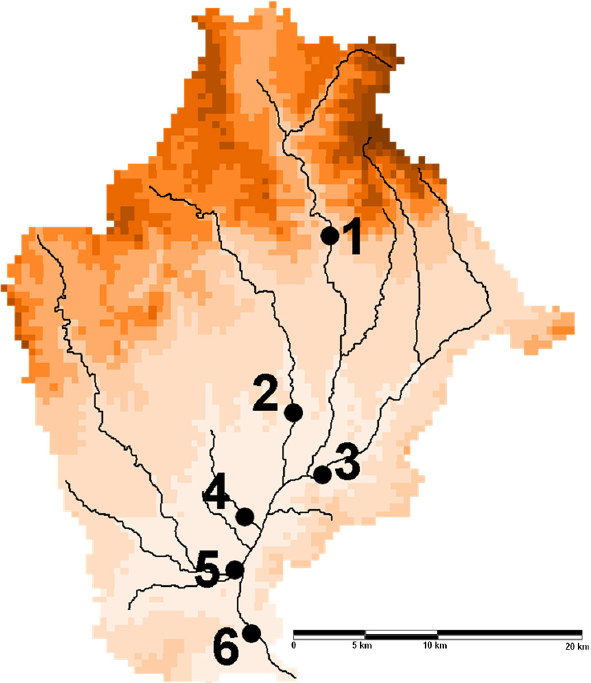
Fig. 2. Location of the river gauging stations within the Besos basin: 1-Garriga; 2-Llic¸a; 3-Mogent; 4-Mogoda; 5-Montcada; 6- Gramenet.